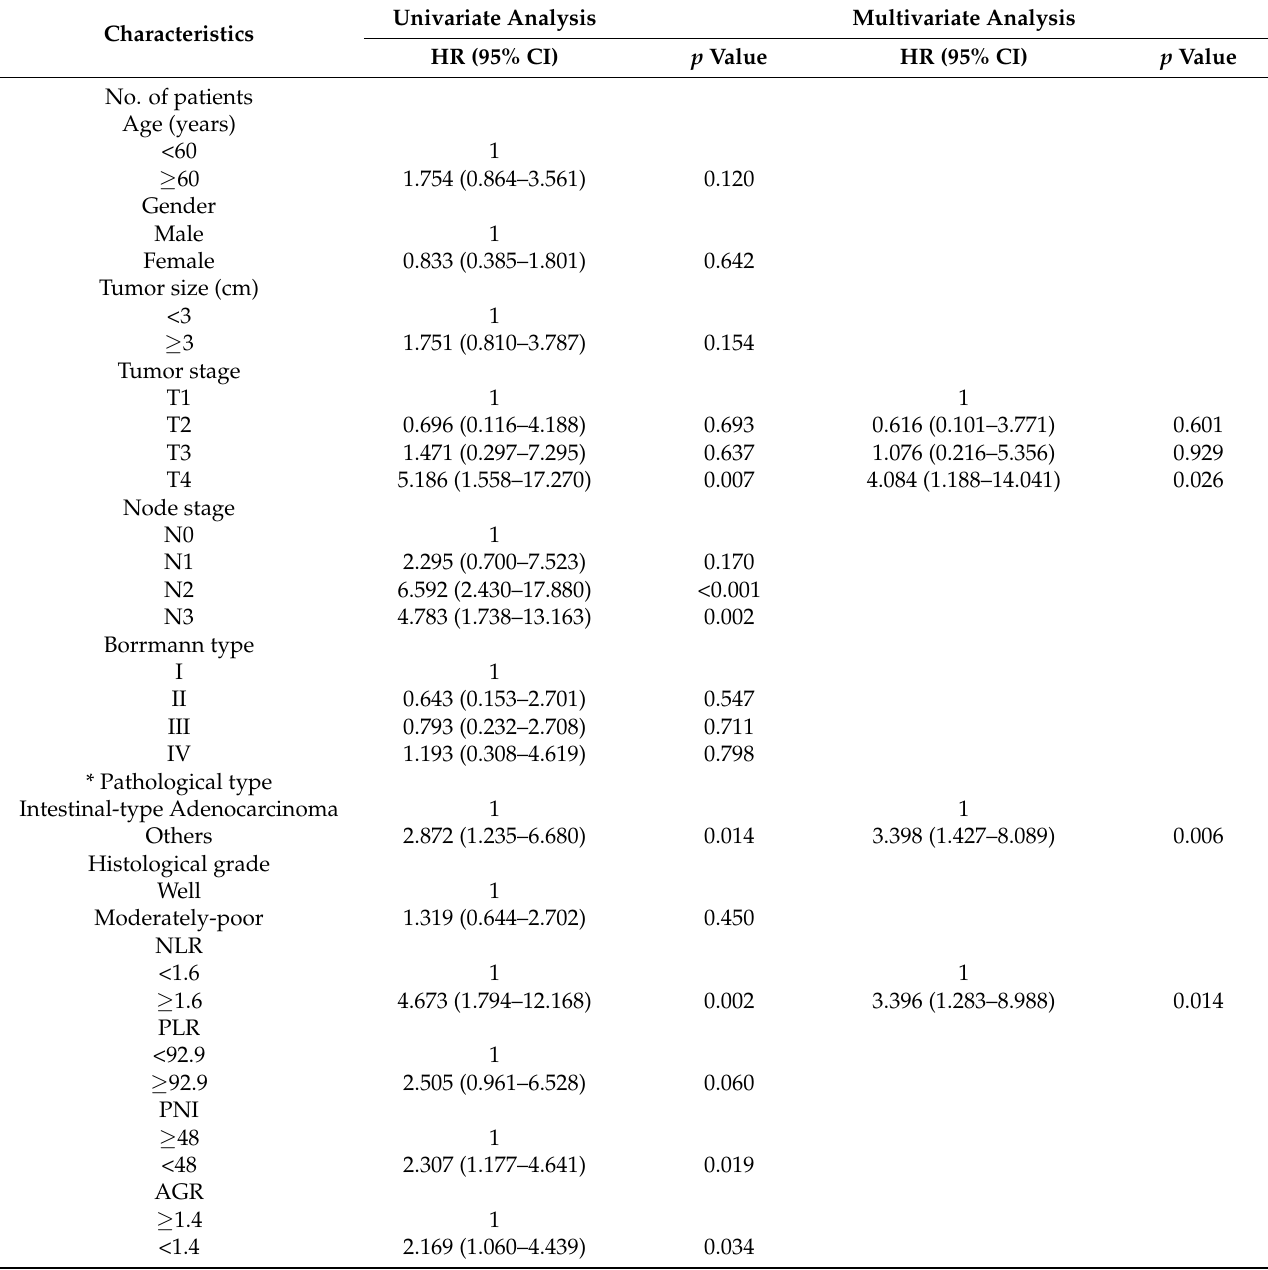
Table 2. Univariate and multivariate Cox hazard analysis of the primary